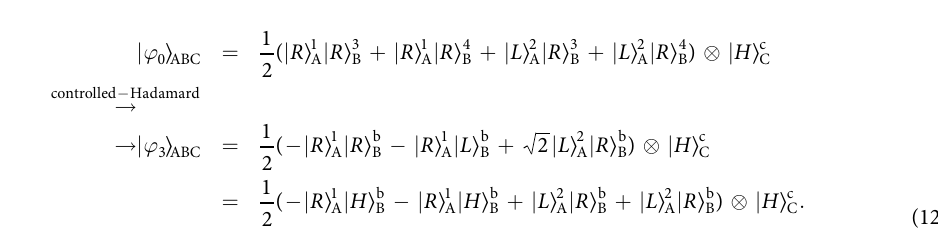
Figure 5. The parity gate: This parity gate utilizes the interaction which can be described by reflection operator ˆ R in Eq. 6, between two photons (B and C) and an electron 1 in QD1 (QD-cavity system) for g / κ = 2.4, κ = κ /2. This gate can arrange polarizations of two photons B and C, such as R L L R { , } γ / κ = 0.1, and ω − ω c (odd) and R R L L {